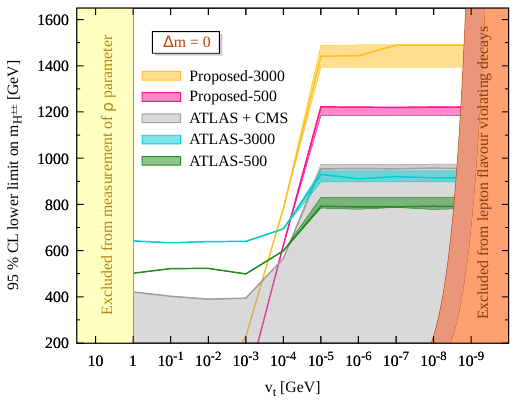
Figure 8 . 95% CL lower limits on m as a function of v t for ∆ m = 0 . The gray shaded region H ±± is excluded from the existing CMS and ATLAS combined search at the 13 TeV LHC. The bands resulted from different possible neutrino mass hypotheses. See text for